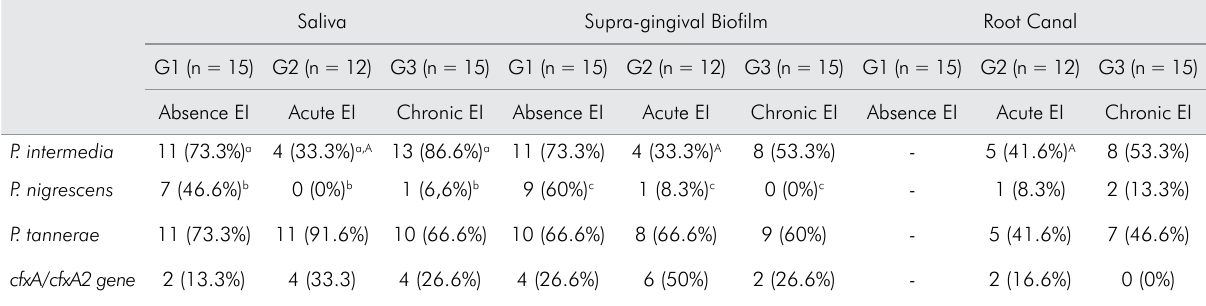
Table 1. Frequency and percentage of each Prevotella species and cfxA/A2 gene in the collected samples.